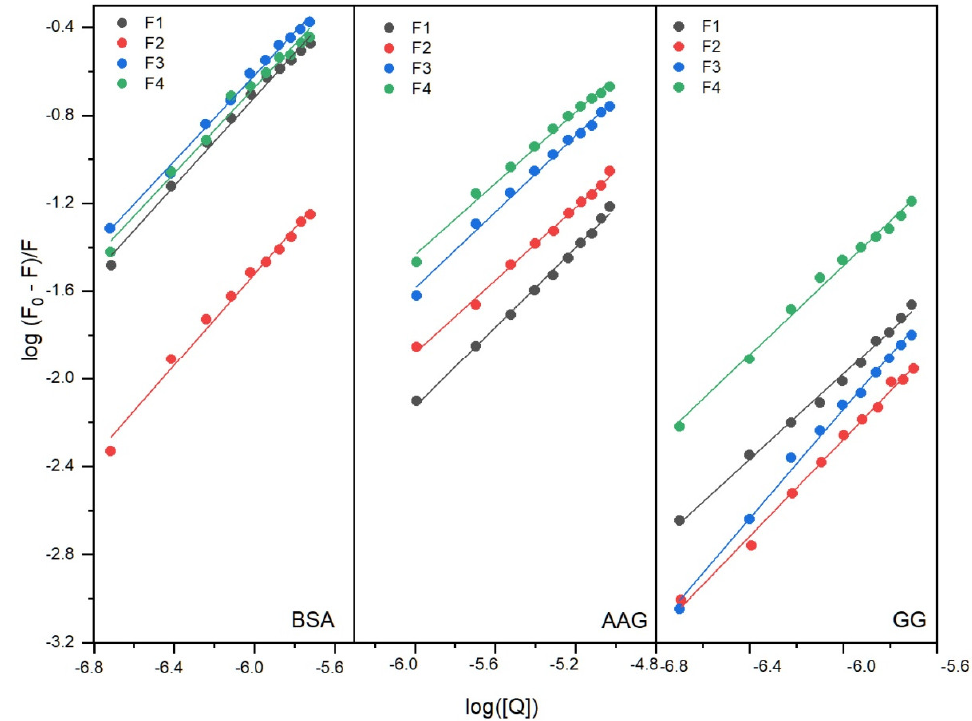
Figure 3. Double logarithm regression plots for quenching of BSA, AAG, and GG by compounds